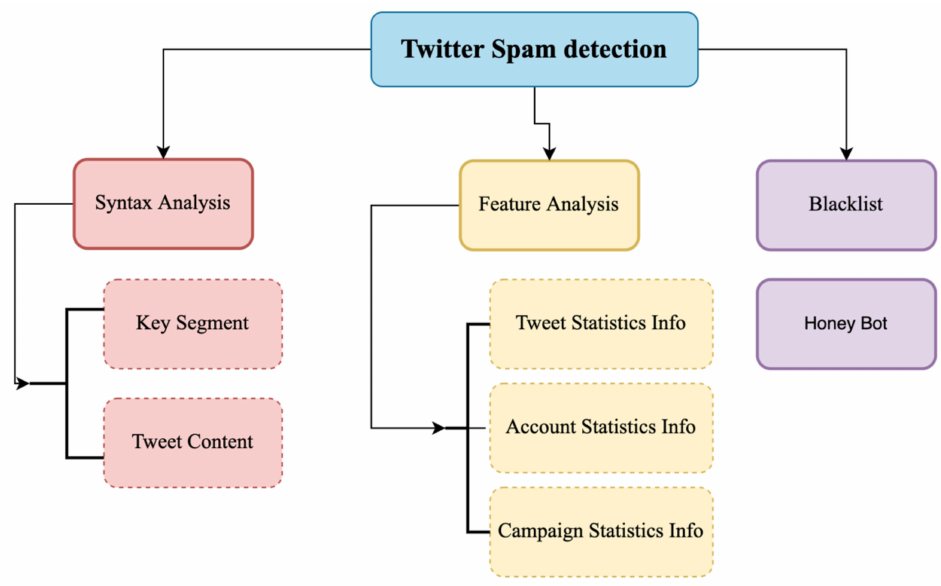
Figure 1. Twitter spam detection